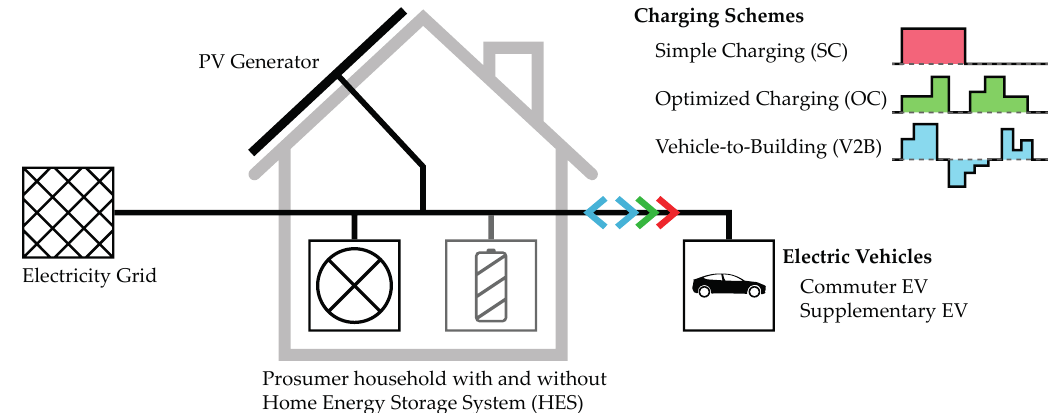
Figure 1. Schematic structure of the simulation environment of a prosumer household with three varying simulation dimensions: Consideration of home energy storage system (HES), two electric vehicle (EV) utilization patterns (commuter and supplementary car), and three different charging schemes (SC, OC,